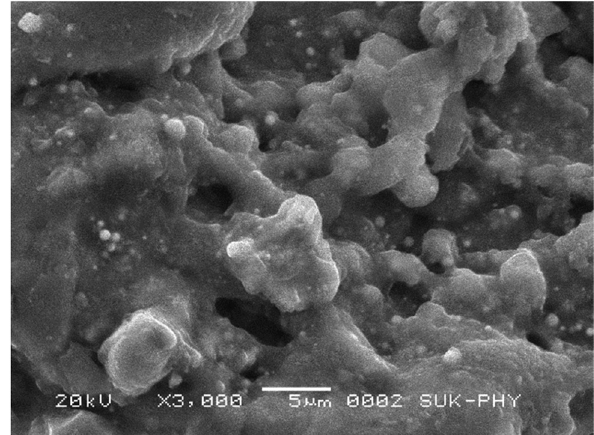
Figure 11: Pores of machined surface. (cid:129) The best combination of process parameters in the PMEDM process was determined to be current ( 3 A ) , pulse on - time ( 37 μ s ) , pulse o ff - time ( 37 μ s ) , and powder concentration ( 4 g/L ) .